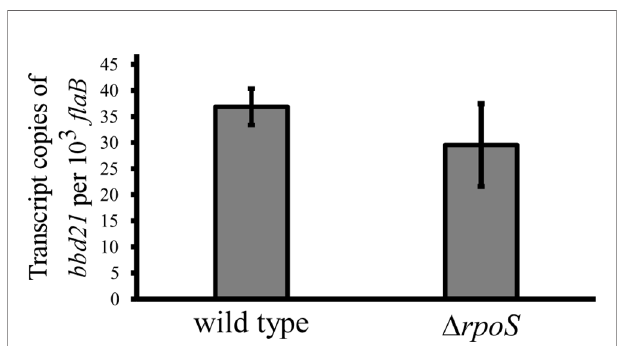
FIGURE 6 | bbd21 transcription is independent of rpoS regulation. Mammalian host-adapted spirochetes were generated in dialysis DMCs implanted into the peritoneal cavity of rats. Transcription of bbd21 was compared by qRT-PCR analysis of wild-type and D rpoS spirochetes in three independent experiments. Gray bars represent mean values of bbd21 transcript copies normalized to 10 3 fl aB , and error bars represent standard error mean. There is no statistical difference between the two strains (Student ’ s t